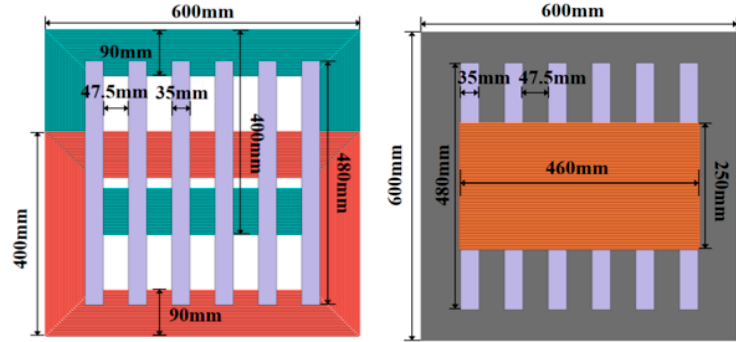
Figure 8. Design parameters of the proposed transformer structure.